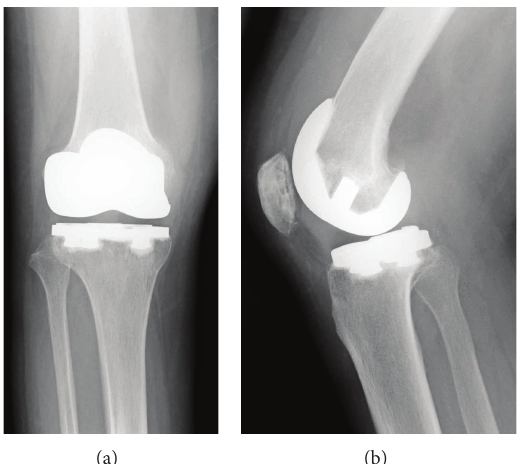
Figure 1: Anteroposterior (a) and lateral (b) radiographs of the patient’s right knee at the first visit. No signs of infectious loosening or osteolysis around the prosthesis were detected.